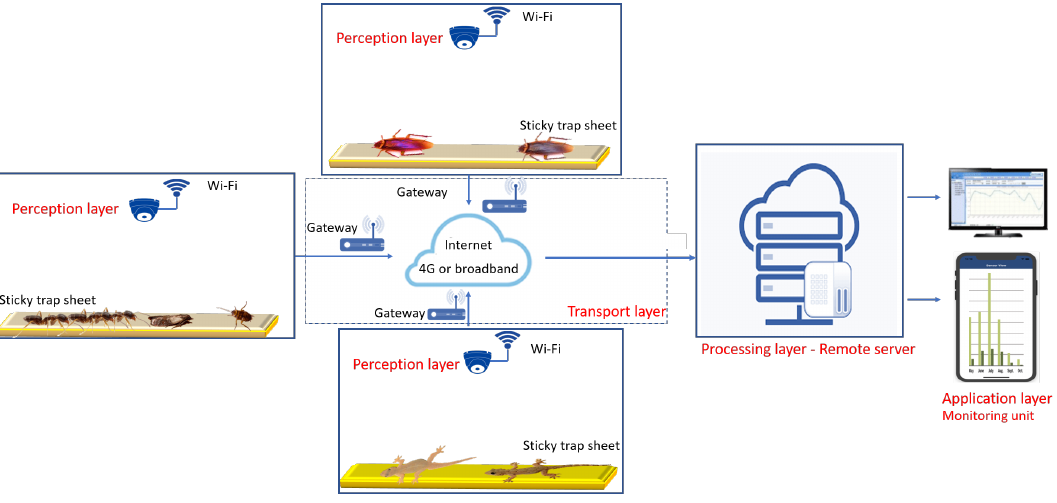
Figure 1. Overview of Internet of Things (IoT) based insect detection